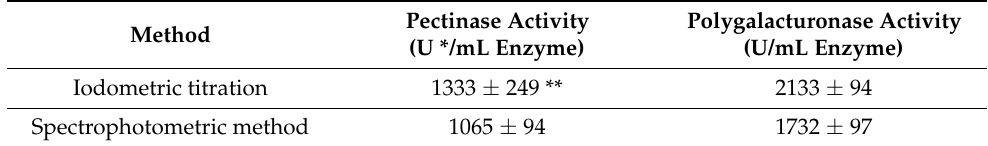
Table 1. Pectinase and polygalacturonase activities of Pectinex Ultra SPL preparation determined using titration and spectrophotometric methods.